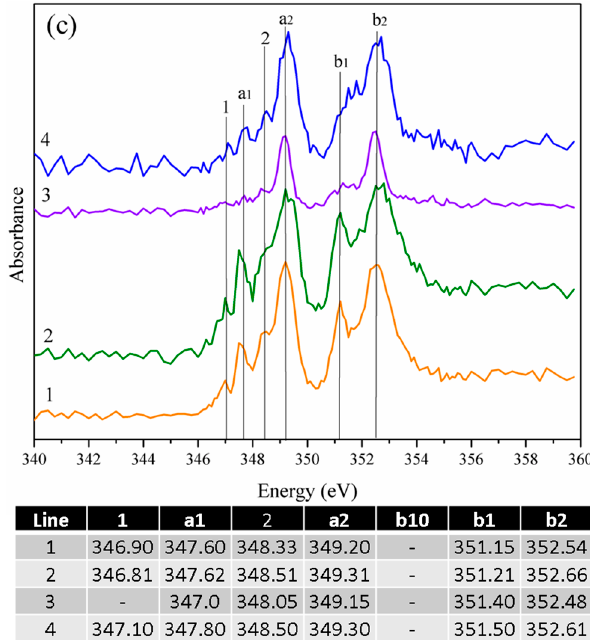
Figure 4. ( a ) Image taken at the calcium L II,III edge of the orthorhombic C 3 A sample; ( b ) calcium L II,III edge of the area underlined in ( a ); and ( c ) NEXAFS spectra of the line scans indicated in ( b ).